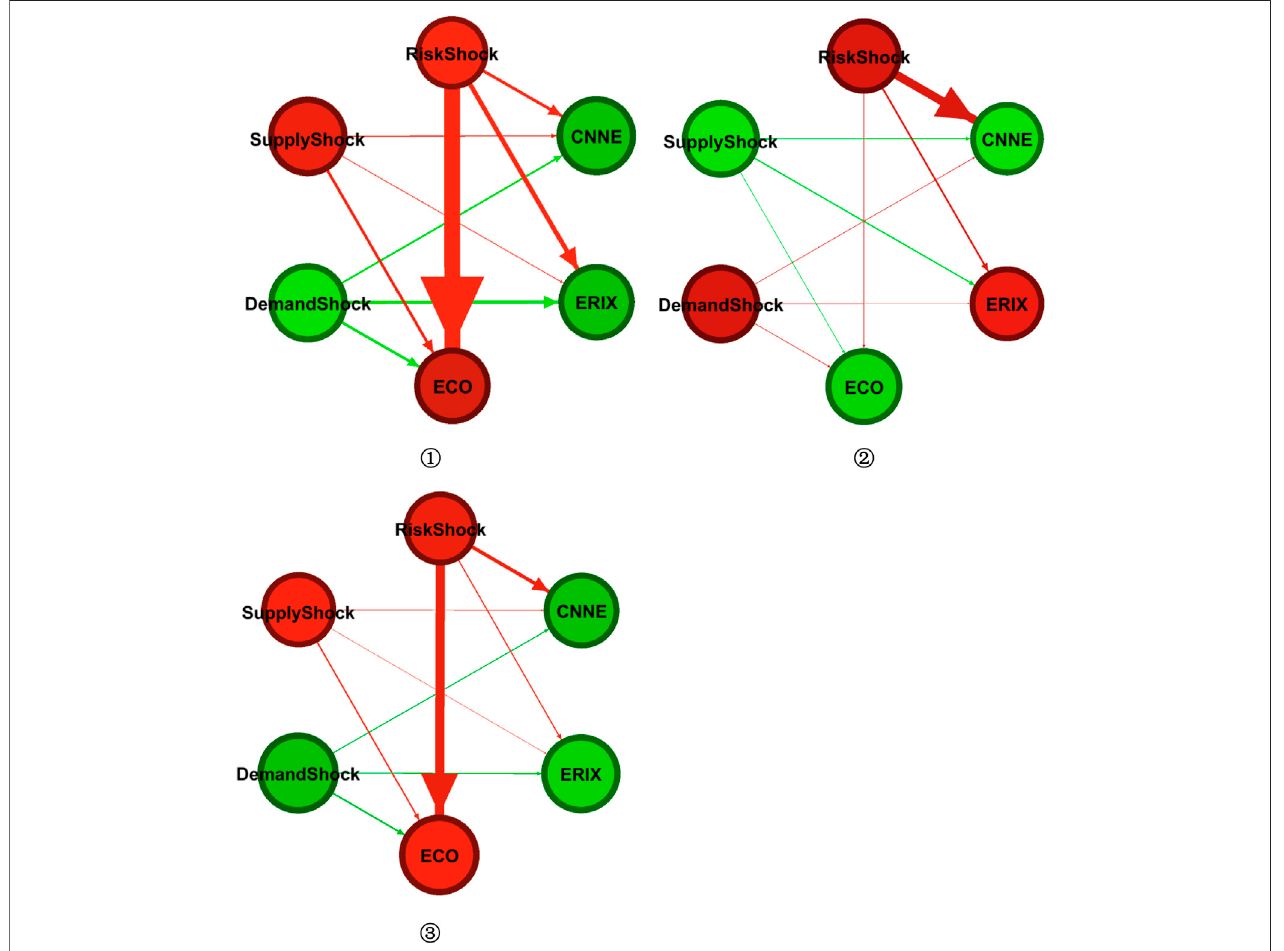
FIGURE 6 | Directional net connectedness network of oil shocks and new energy returns for different sub-samples.